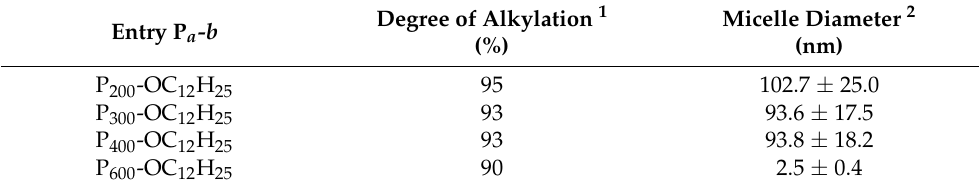
Table 3. Dependence of micelle diameter of POEAP from PEG’s length.